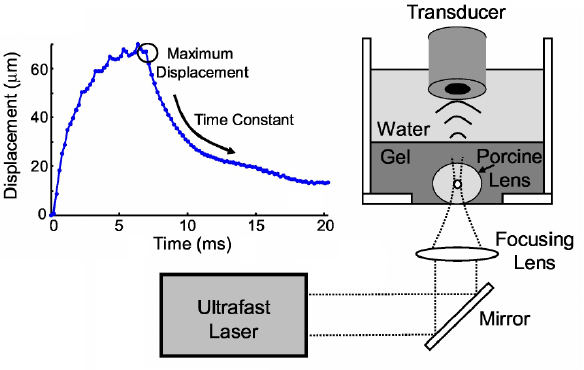
Figure 11. ( Right ) Sketch of an experimental setup for oscillating bubble-based measurements with in vitro porcine eye lenses. Microbubbles are generated across the equatorial plane of a lens using laser-induced optical breakdown. Piezoelectric transducers irradiate bubbles with a MHz-range ultrasound and receive pressure waves scattered by them thereby allowing one to measure both the displacement of bubbles with respect to their initial positions and their temporal responses. ( Left ) Typical experimental bubble displacement curve. Along with the exponential time constant of the bubble temporal responses, knowledge of the maximum displacement enables determining mechanical properties of the lens tissues. Reproduced from [167]. Copyright 2007, with permission from